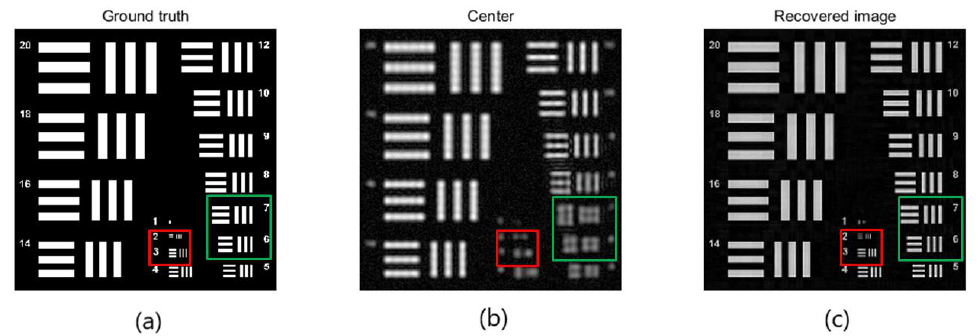
Figure 5. Effect of long-range images is a reconstruction using Fourier ptychography (FP) technology. ( a ) Ground truth: we simulate imaging a 64 × 64 mm resolution target 50 m away using the sensor with a pixel pitch of 2 µ m. The width of a bar in group 20 is 25 mm. ( b ) Center image: The target is observed using a lens with a focal length of 800 mm and an aperture of 18 mm. The aperture is scanned over a 17 × 17 grid (61% overlap) creating a synthetic aperture of 130.2 mm where the synthetic aperture ratio (SAR) is 7.24. We can see it has lost at least 14 pixels of its features due to the low-pass filtering of the aperture. ( c ) Recovered image: Using FP technology to restore high-frequency information, the resolution of the image can be improved, at least to restore the characteristics of 2 pixels.